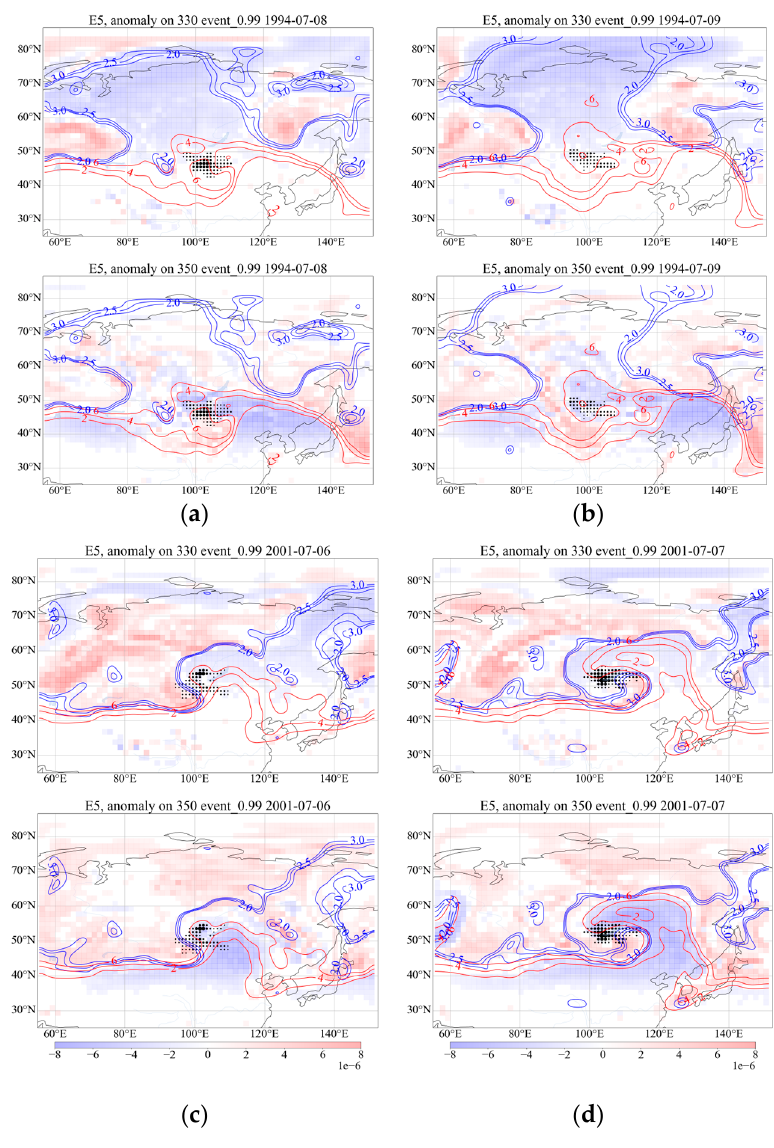
Figure 6. Event 1: 8th ( a ) and 9th ( b ) July 1994; and event 2: 6th ( c ) and 7th ( d ) July 2001. 2–6 PVU contours are shown: red—350 K, blue—330 K. The anomalies of PV are shown by filling, at 330 K (upper figure) and 350 K (lower figure). The black dots correspond to the precipitation areas.